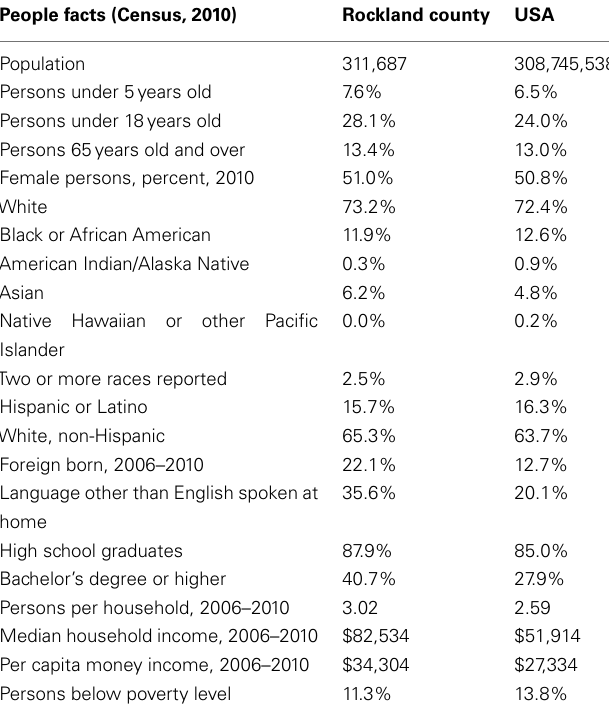
Table 1 | 2010 United States census data: Rockland County versus United